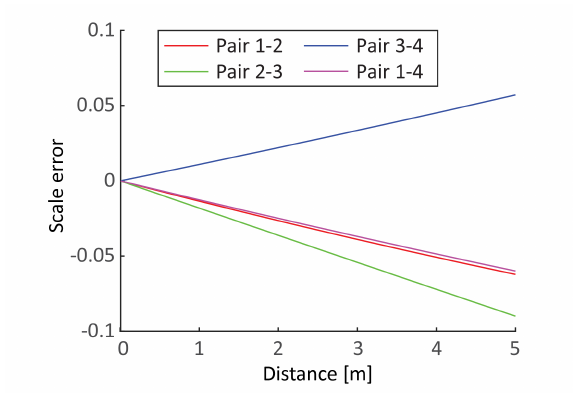
Figure 21. Error induced in scale error estimate due to disregarding nonparallelism of laser beams.